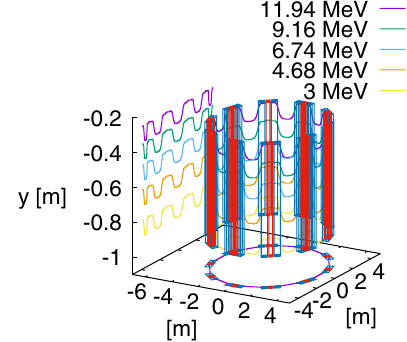
FIG. 3. Closed orbits for different momenta in the FDF triplet lattice. The locations of the Bd and Bf magnets are indicated by red andblueboxesrespectively.Theratioofmagnetstrength B 0 − 0 . 20 and the value of the normalized field gradient m is fixed at 1 . 28 m − 1 . Path lengthisconstantforthe entire momentumrange, in other words, the momentum compaction factor is zero.